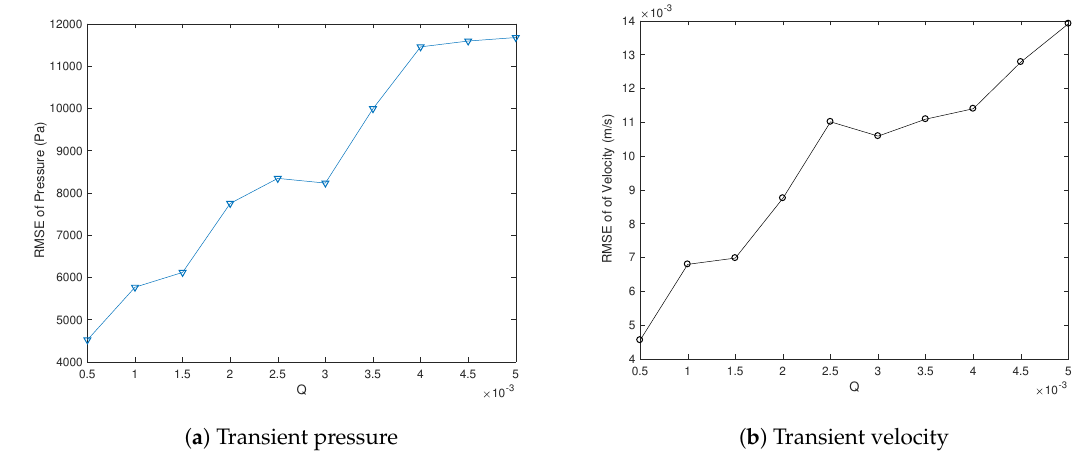
Figure 8. RMSE of estimated outputs of the water hammer system (R =